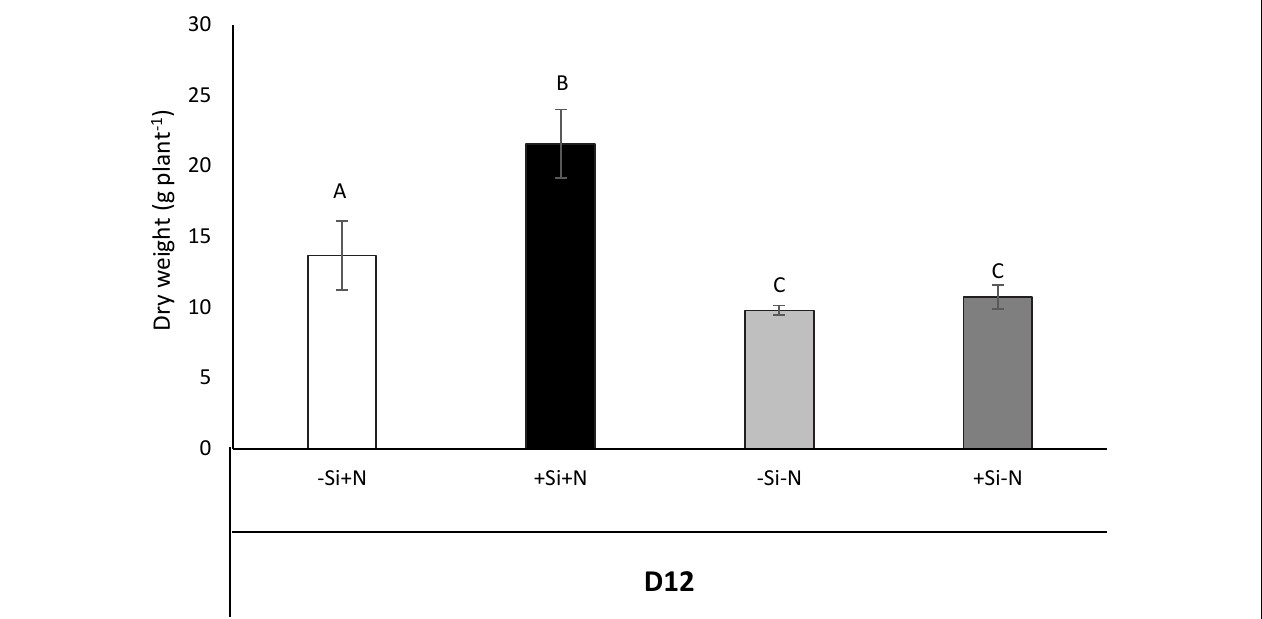
FIGURE 4 | Effect of Si pretreatment on total dry weights of Brassica napus L. supplied or not supplied with N. During the 12 days after the Si pretreatment, control (–Si) and Si pretreated (+Si) plants were grown with (–Si+N, +Si+N) or without N (–Si–N, +Si–N). Data are means ± SE (for n = 3). Different capitals indicate that the means of total plant dry weights are significantly different at p <